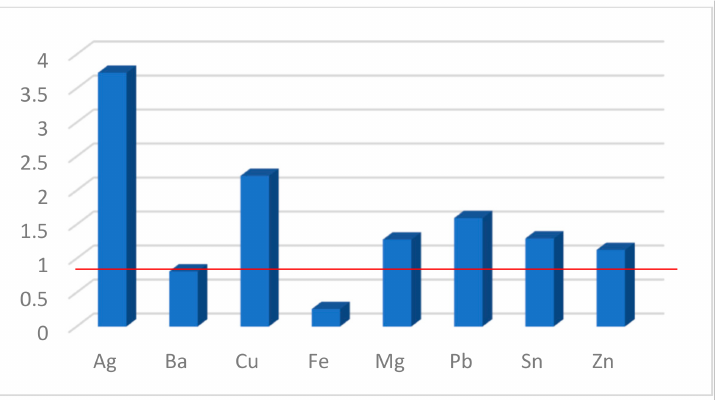
Figure 7. Fluorescence enhancement (FE) factors for 1b in the presence of metal